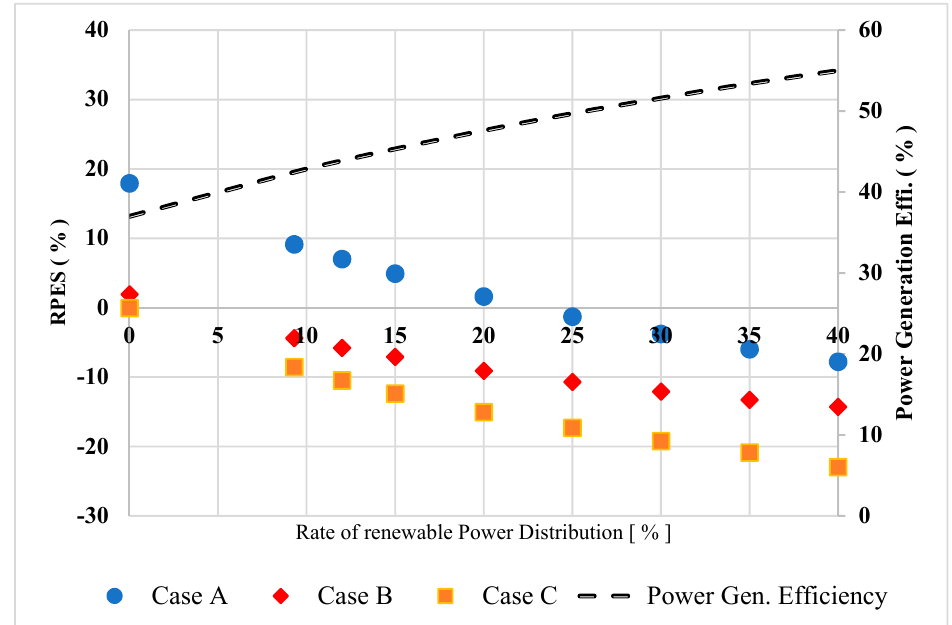
Figure 21. RPES performance of TSG against SHP according to the share of renewable generation in the national grid power sector.